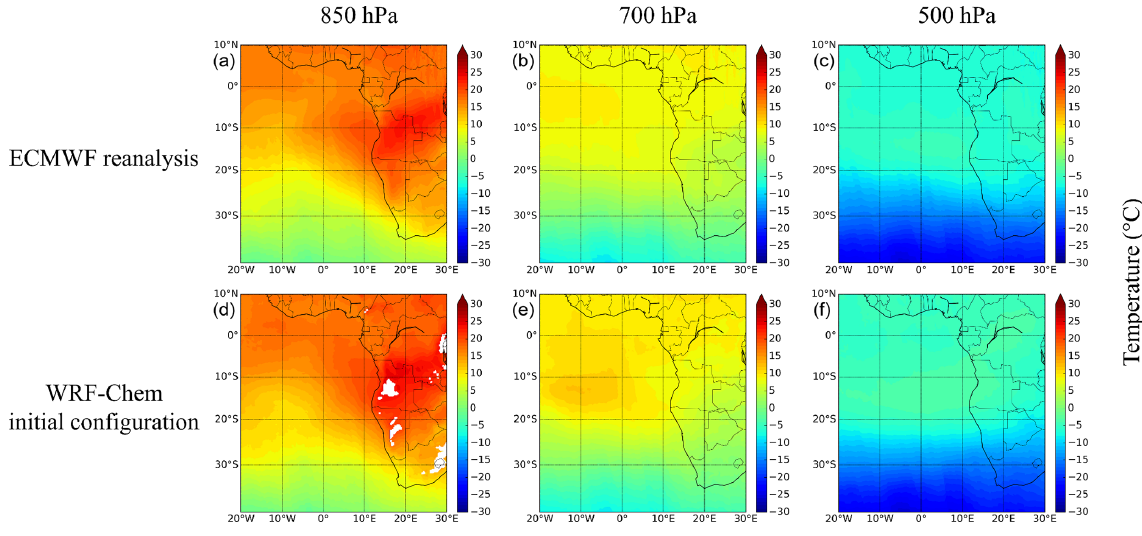
Figure 6. Same as Fig. 4 but for temperature (in ◦ C). Table 3. Meteorology performance statistics of WRF-Chem initial configuration compared to ECMWF ERA-Interim reanalyses. WSPD, WDIR, Q and T represent the wind speed, the wind direction, the specific humidity and the temperature respectively. N , ME, MAE, RMSE and CORR represent the number of coincident data pairs, the mean error, the mean absolute error, the root mean square error and the spatial Pearson correlation coefficient, respectively. The units of the statistical parameters are the same as meteorological variables. 850hPa 700hPa 500hPa WSPD WDIR 31884